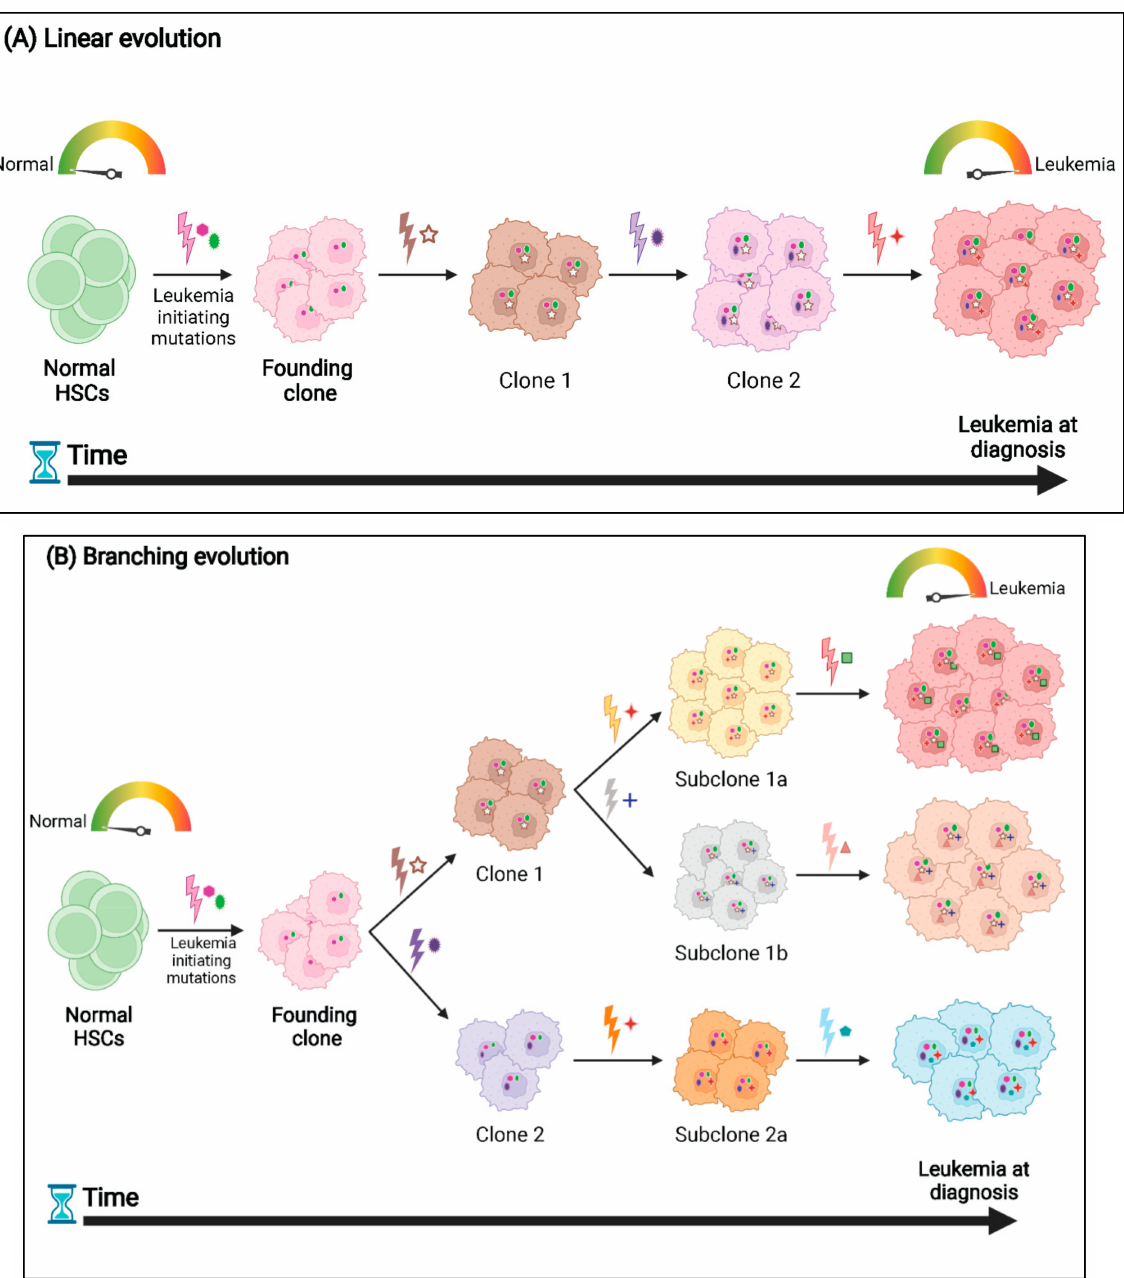
Figure 2. Patterns of clonal evolution: A normal HSC is transformed via the acquisition of leukemia driver mutations, which gives rise to a founding clone. ( A ) Linear evolution: The founding clone might acquire successive driver mutations in a stepwise manner such that each daughter clone contains all the mutations of the parental clone. ( B ) Alternatively, leukemias might follow a branched evolutionary pattern, wherein the founding clone can diverge into several daughter clones, which then evolve in parallel. During branching evolution, two parallelly evolving clones might acquire the same mutation leading to convergent evolution, as depicted in subclones 1a and